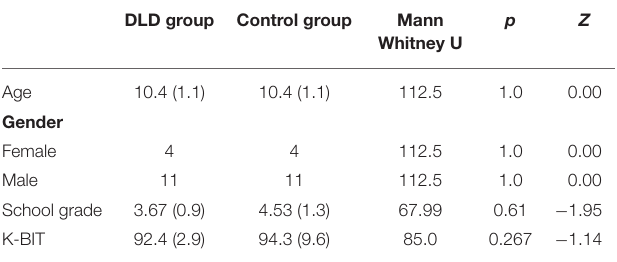
TABLE 1 | Sociodemographic data of